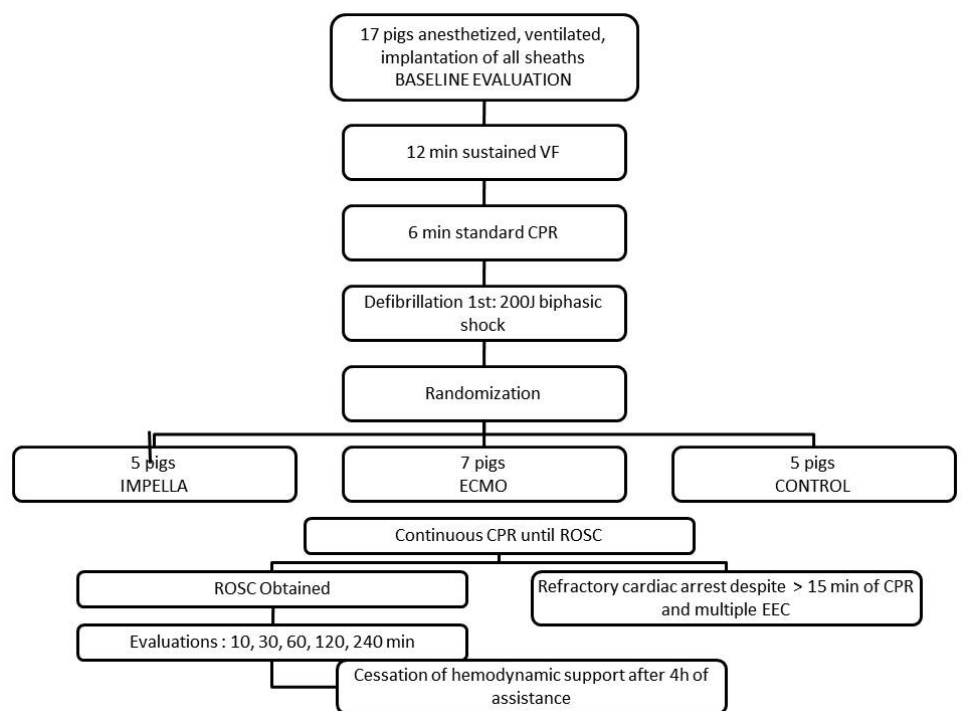
Figure 1. Study design.